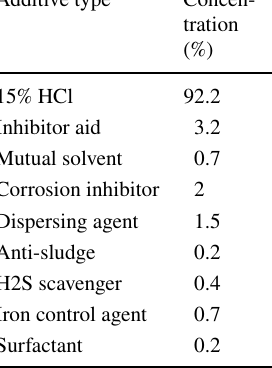
Table 10 Concentration of additives in acidizing operation